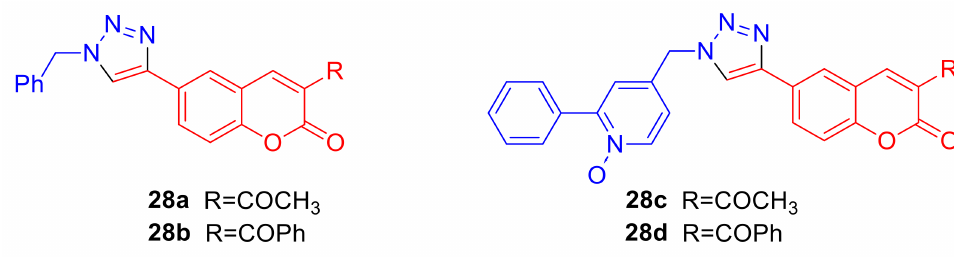
Figure 1. Coumarin hybrids tethering 1,2,3-triazole moiety. The greenness of visible light as an alternative energy source has attracted more attention in the last years. The photoredox catalysis induced by visible light was then examined by Wu and co-workers in 2020 as a new pathway for the synthesis of 1,4- DTs [45]. The authors demonstrated that the photocatalyzed AAC (PcAAC) is possible, by exploring diverse common photocatalysts, such as Eosin Y, [Ru(bpy) 3 Cl 2 ] · 6H 2 O, [Ir(ppy) 3 ], [(piq) 2 Ir(acac)] ( 31 ) and others, in different solvents, and under different light-emitting diodes (LEDs). The best reaction conditions were founded using [(piq) 2 Ir(acac)] ( 31 ) as a catalyst in dichloromethane as a solvent for 6 h under white LED irradiation (Scheme 11).